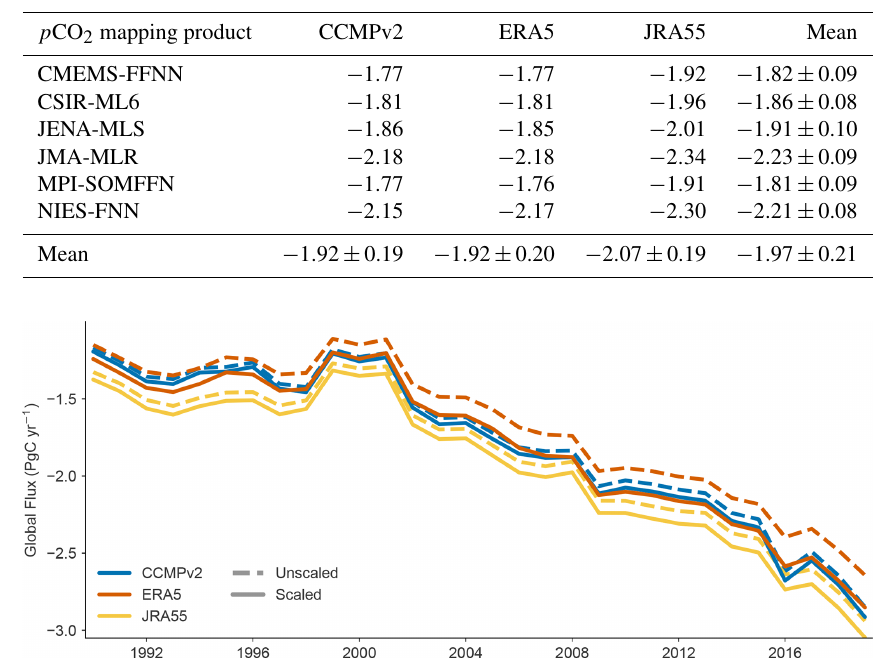
Figure 4. CSIR-ML6-calculated air–sea CO 2 flux time series for various wind speed products, scaled (solid) and unscaled (dashed; a = 0 . 251). Time series plots for all p CO 2 products and including two additional wind products (NCEP1 and NCEP2) are included in Fig.